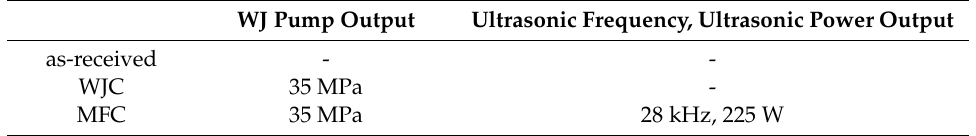
Table 2. Processing conditions of low alloy steel. (WJC: water jet cavitation; MFC: multifunction